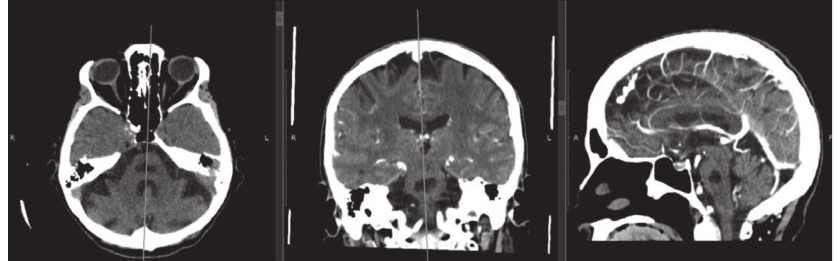
Figure 3: Cranial computed tomography showing a hypoattenuating focal area in the central region of the pons (sequences: axial, coronal, and